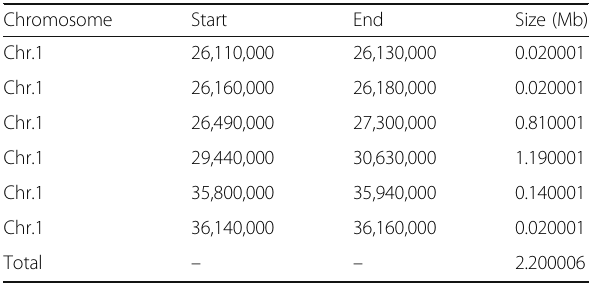
Table 4 The detailed positions of the candidate regions for salt tolerance in CMG